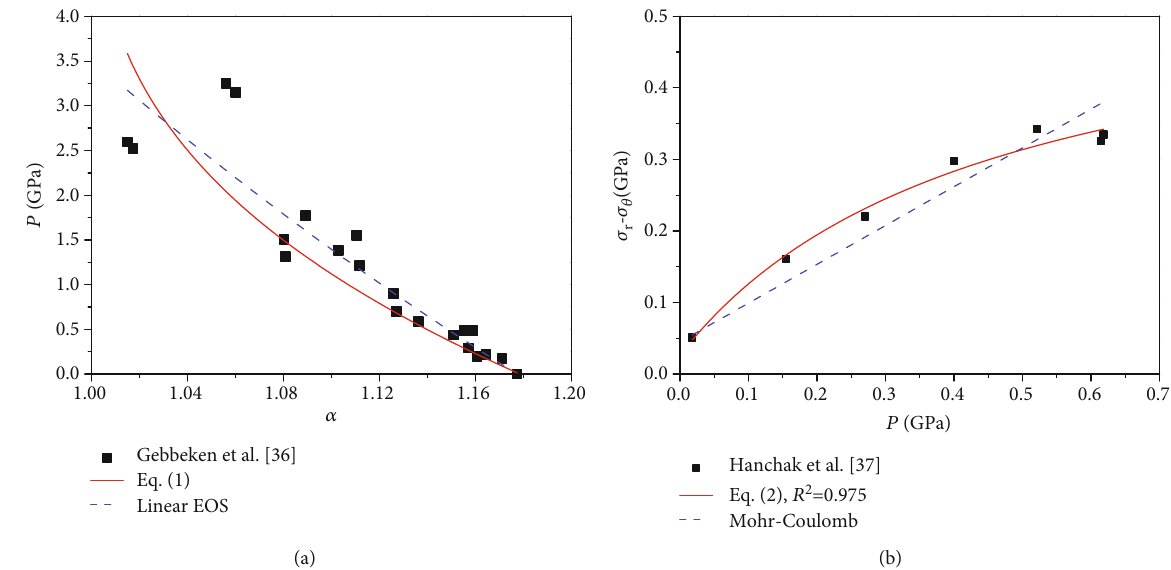
Figure 2: Test data and proposed constitutive laws for 51MPa concrete: (a) EOS and (b) yield criterion.